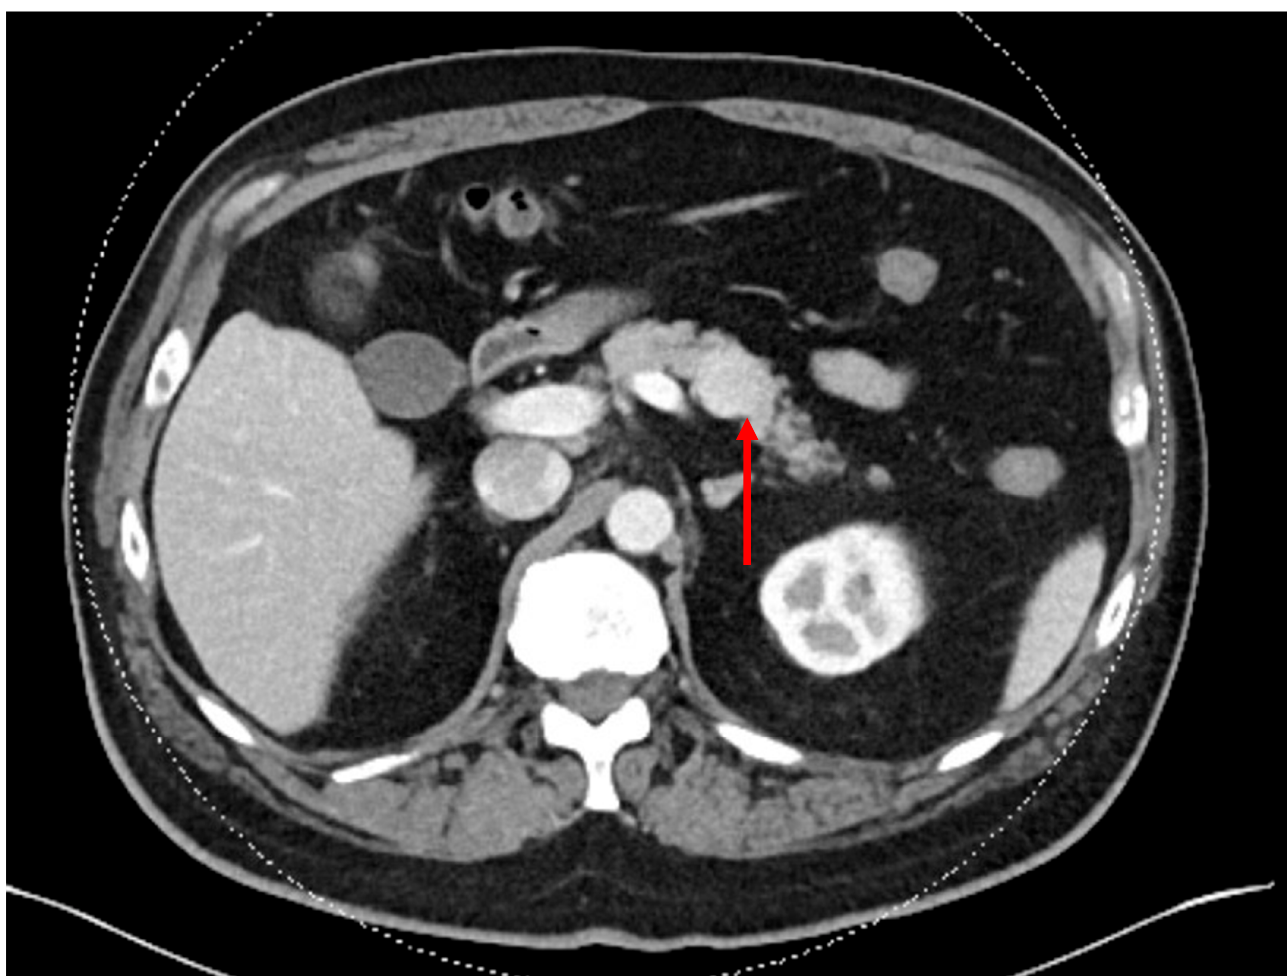
Figure 1. Contrast-enhanced CT demonstrating an incidental well-circumscribed 2.3 cm pancreatic mass (red arrow). The mass is enhanced relative to pancreatic parenchyma, consistent with a non- functioning pancreatic neuroendocrine